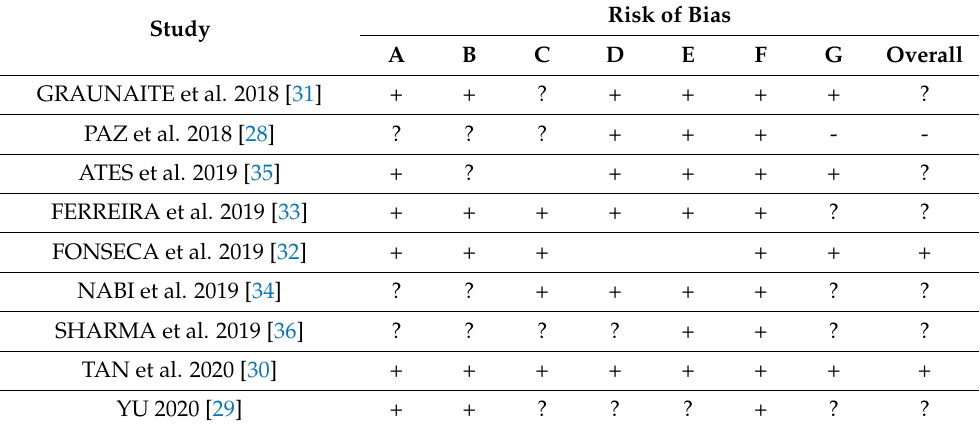
Table 2. Summary of the risk of bias of the included studies.